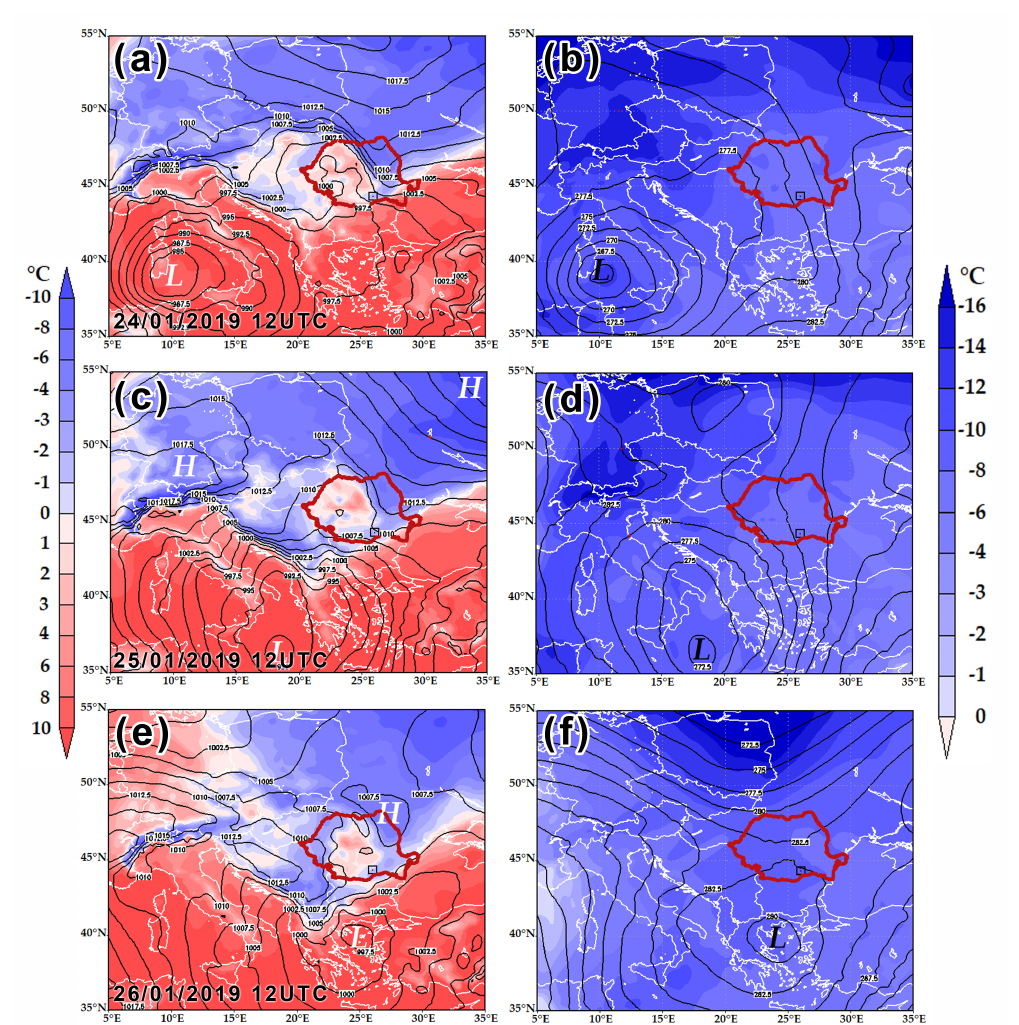
Figure 3. Synoptic analysis of freezing rain event between 24–26 January 2019 at 12 UTC, from ERA5. ( a , c , e ) shows mean sea level pressure (black contours) and 2 m temperature (shaded according to the scale). ( b , d , f ) shows the 700 hPa geopotential height (black contours) and temperature (shaded according the scale). The black rectangle marks the position of